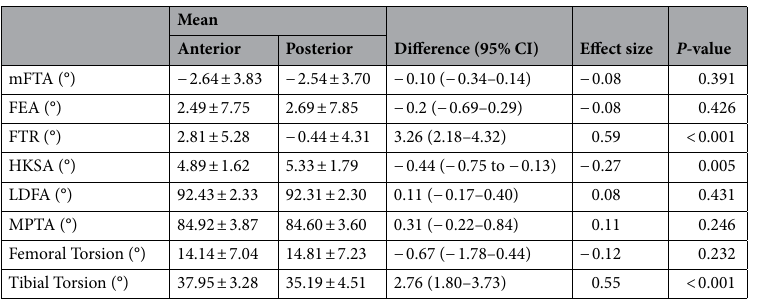
Table 1. Comparison of the alignment values on the EOS 3D model according to the posture of the indexed lower